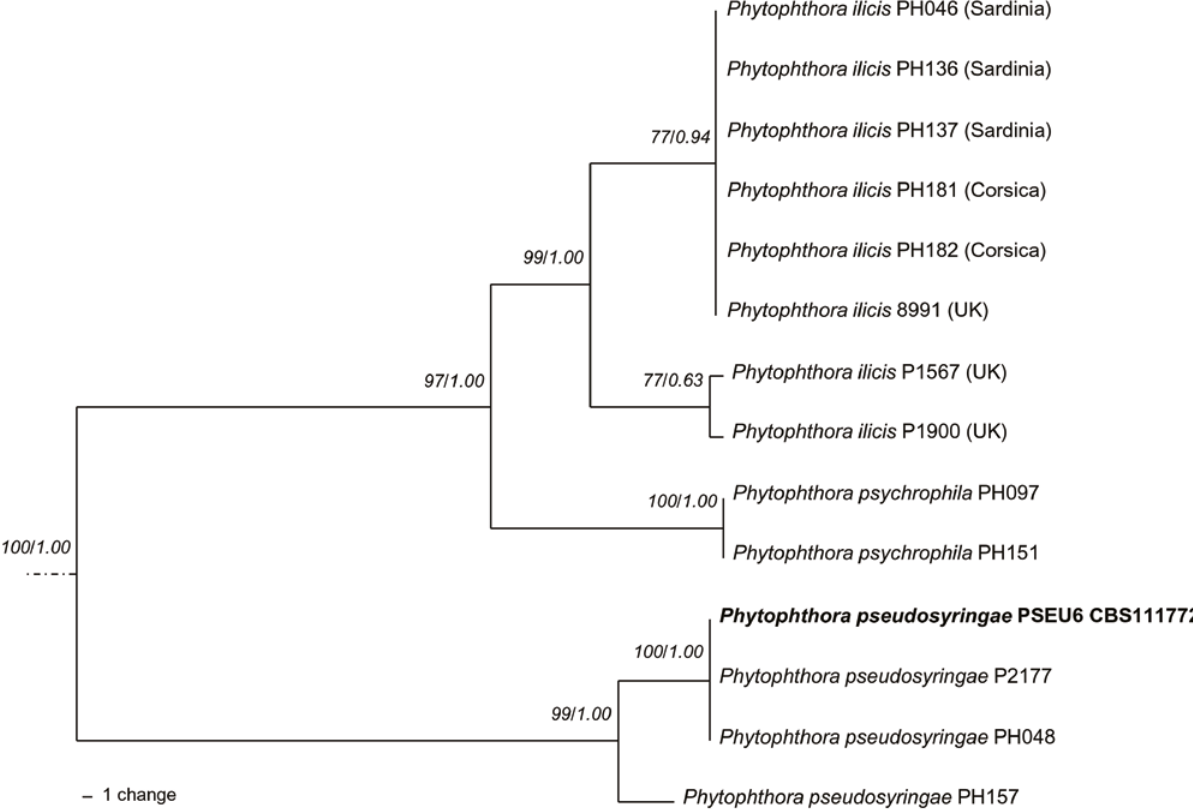
Figure 3. Phylogeny of Phytophthora Clade 3 species based on the cytochrome oxidase I gene region. The tree is the most parsimonious, obtained from a heuristic search (CI = 0.928, RI = 0.962). Bootstrap support and posterior probability values are given at the nodes. Ex-type cultures are in bold. The phylogram is rooted to P . parvispora (CBS 132771/KC609412 and CBS 132772/